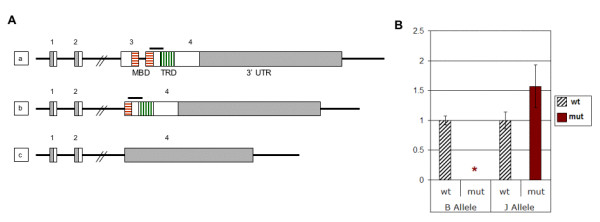
Structure and expression of Mecp2 mutant alleles. A. Genomic structure of Mecp2 mutations. a. Wild-type Mecp2 gene. MBD, methyl-CpG binding domain; TRD, transcription repression domain. White or hatched: coding sequence. Grey: non-coding parts of transcript. Exons 1 and 2 that are alternatively spliced, and intron 2, are not drawn to scale. Horizontal bar above exon 4 denotes location of the amplicon analyzed by qRT-PCR (in Figure 1B) b. The Mecp2tm1.1Jae (J-allele) mutant has a deletion of exon 3 that encodes the N-terminal half of the MBD. c. In the Mecp2tm1.1Bird (B-allele) mutant, exon 3, the coding portion of exon 4 and part of the 3'UTR are deleted. This larger deletion eliminates ~ 97% of the coding sequence. B. Real-time quantitative RT-PCR analysis of Mecp2 expression in cerebellum. Using primers within the deleted region, Mecp2 transcript was undetectable in mutant mice with the B-allele, when four wild-type and four mutant samples were compared at 8 wk. This proves the specificity of the primers. In mice with the J-allele, mean Mecp2 expression was higher in the mutants, but this difference was not statistically significant (P = 0.11), when six wild-type and seven mutant samples were compared at 8 wk.